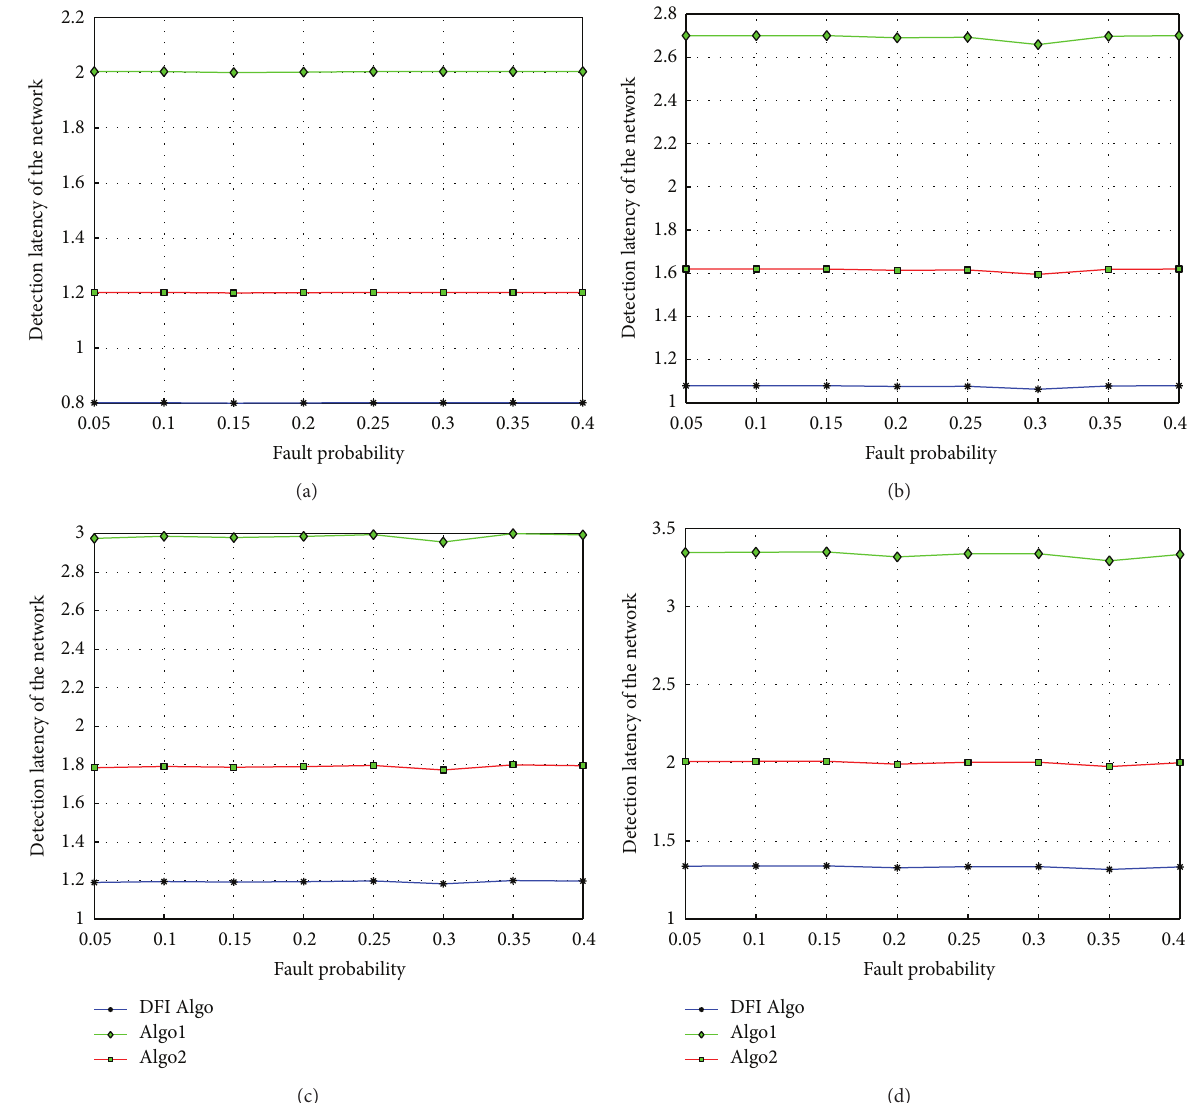
Figure 4: Detection latency versus fault probability for the DFI, Algo1, and Algo2 algorithms: (a) for average degree 𝑁 𝑎 = 10; (b) for average degree 𝑁 𝑎 = 15; (c) for average degree 𝑁 𝑎 = 20; (d) for average degree 𝑁 𝑎 =